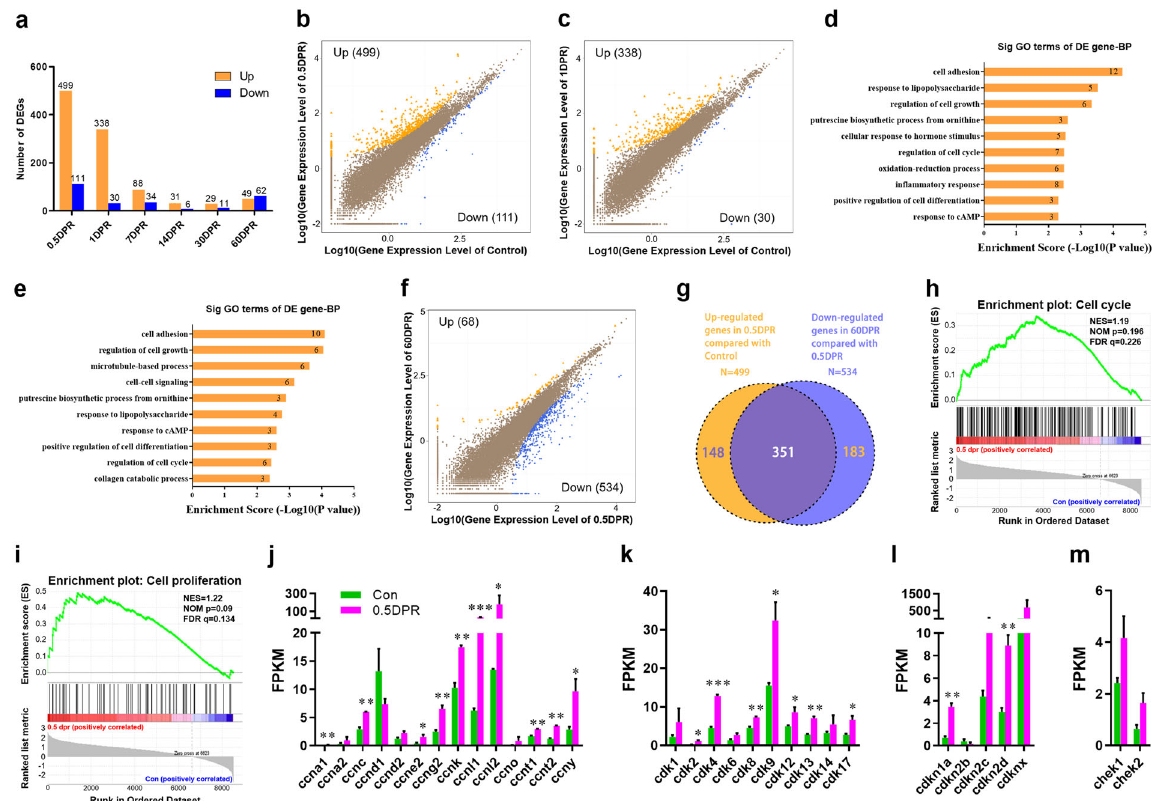
Fig. 4 RNA-seq analysis for sham-operated and resected ventricles of X. tropicalis . a Statistic of differentially expressed genes in resected ventricles compared to control. b , c Overall changes of genes in resected ventricles at 0.5 dpr ( b ) and 1 dpr ( c ) compared to controls. d , e GO analysis of differentially expressed genes in ventricles at 0.5 dpr ( d , 499 plus 111 genes) and 1 dpr ( e , 338 plus 30 genes) over controls. f Overall change of genes in resected ventricles at 60 dpr compared to 0.5 dpr. g Upregulated genes in 0.5 dpr compared with control (499) overlaid with downregulated genes in 60 dpr compared with 0.5 dpr (534). h , i GSEA analysis of heart with apical resection at 0.5 dpr showing high correlations with cell cycle ( h ) and proliferation ( i ) gene sets. j – m Expression of selected genes relative to cyclin ( j ), cyclin-dependent kinase ( k ), cyclin-dependent kinase inhibitor ( l ), and checkpoint kinase ( m ) was analyzed by using the FPKM levels from RNA-seq. All results are presented as mean ± SEM ( n = 3), * p < 0.05, ** p < 0.01, *** p < 0.001 versus control (Student ’ s t